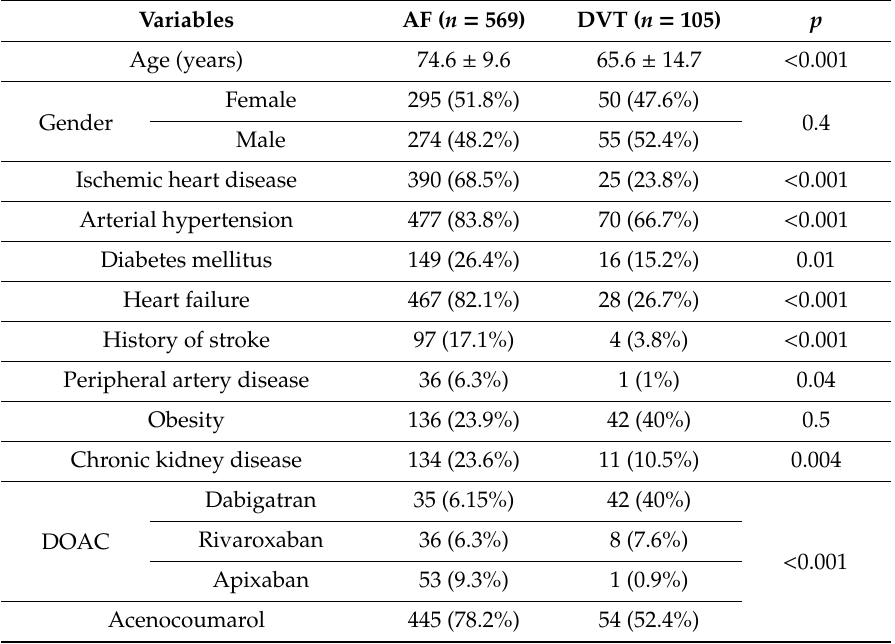
Table 1. Patients’